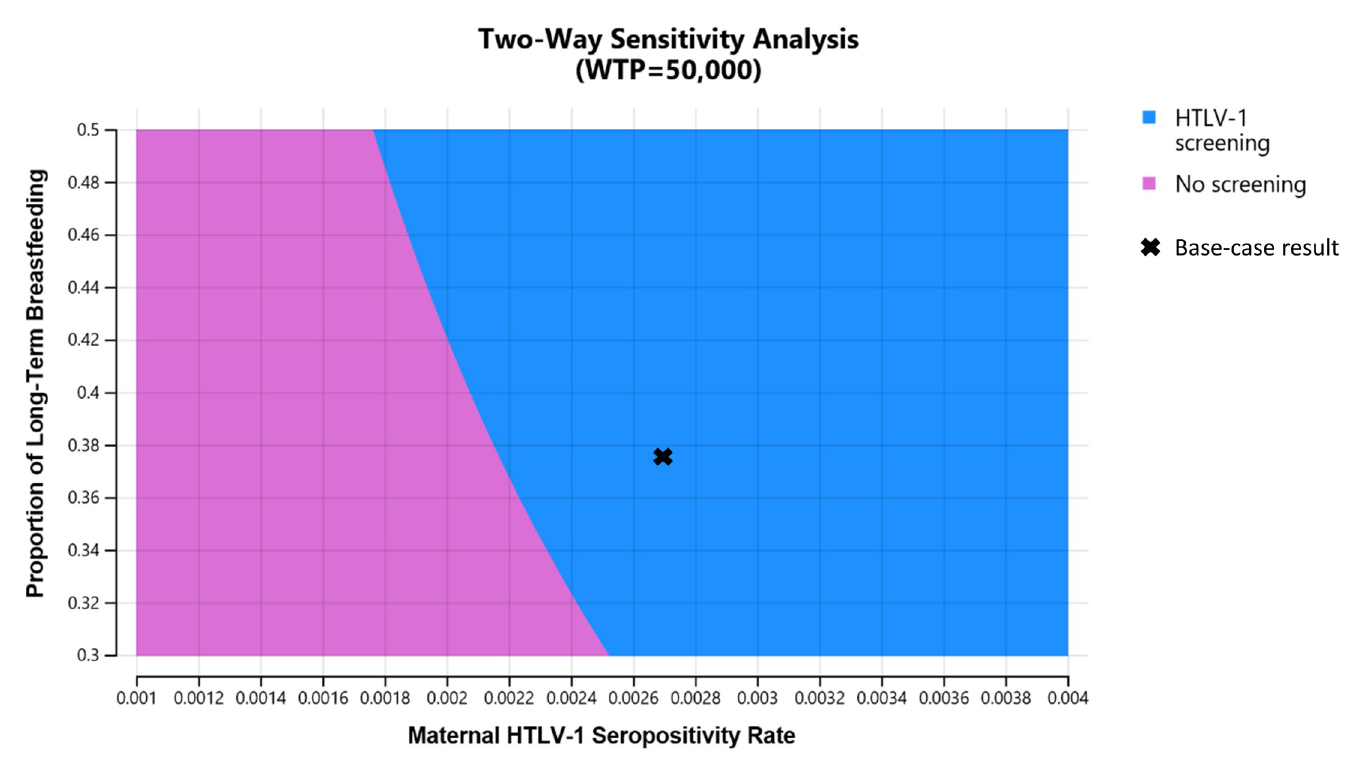
Fig 3. Two-way sensitivity analysis for the maternal HTLV-1 seropositivity rate and the proportion of long-term breastfeeding. HTLV-1 antenatal screening is optimal in the blue region which includes the base-case result (x). No screening is optimal in the orchid region. This figure shows that HTLV-1 antenatal screening is more cost-effective the higher the maternal HTLV-1 seropositivity rate and the higher the proportion of long-term breastfeeding. WTP, willingness-to-pay; HTLV-1, human T cell leukemia virus 1.